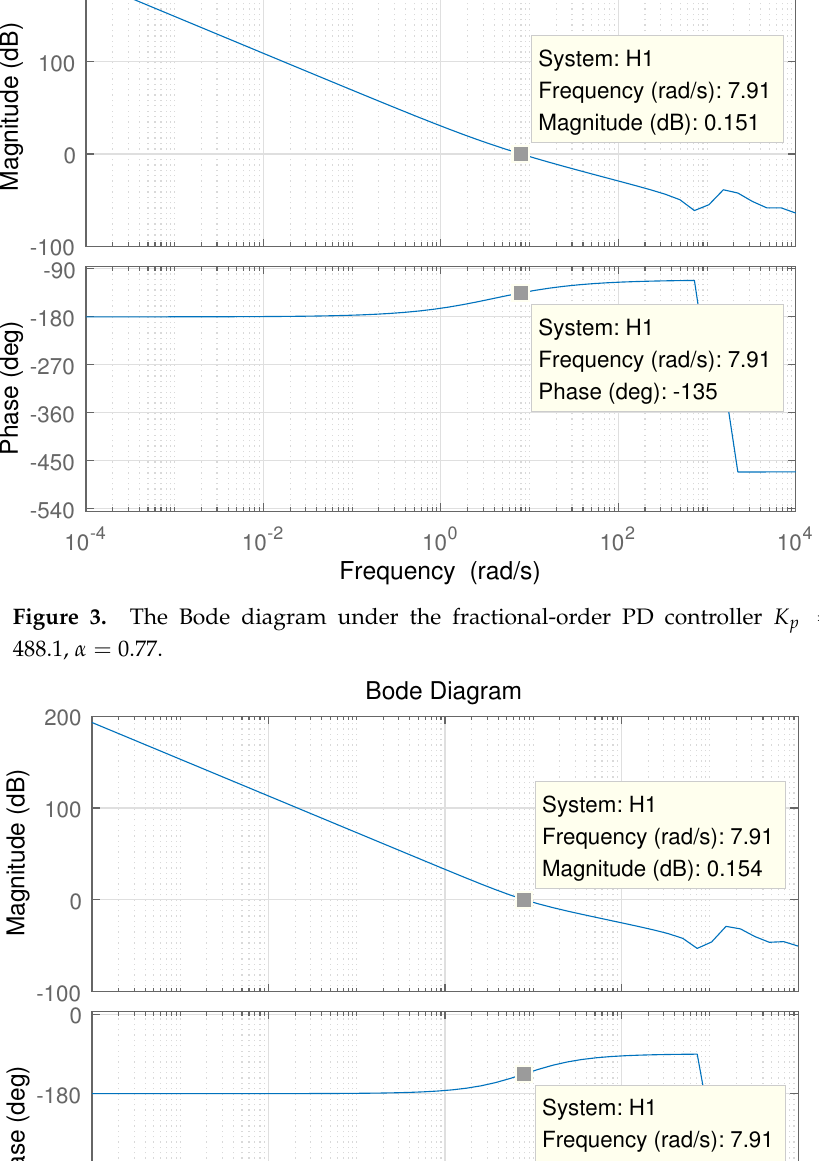
Figure 4. The Bode diagram under the integer-order PD controller K IO p = 2264, K IO